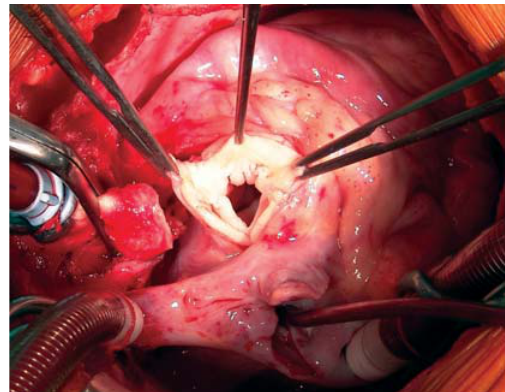
Fig. 3 – Aspecto interno da aorta após a secção transversal demonstrando o anel fibroso a ser ressecado previamente à abertura longitudinal em direção aos três seios